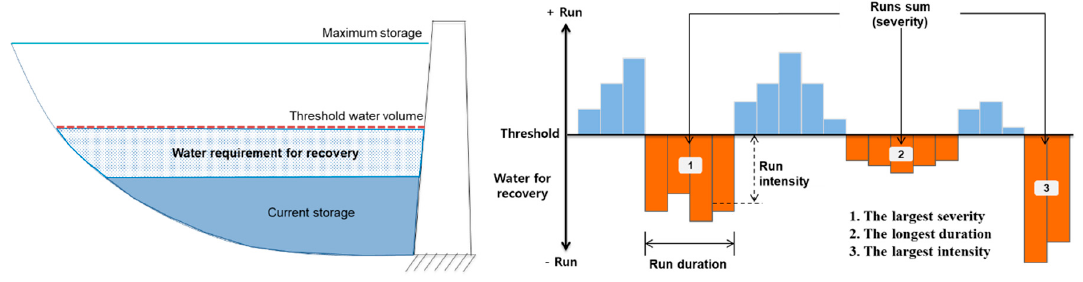
Figure 2. Application of concept of water requirement for recovery and Run theory for analyzing the resilience of a reservoir.